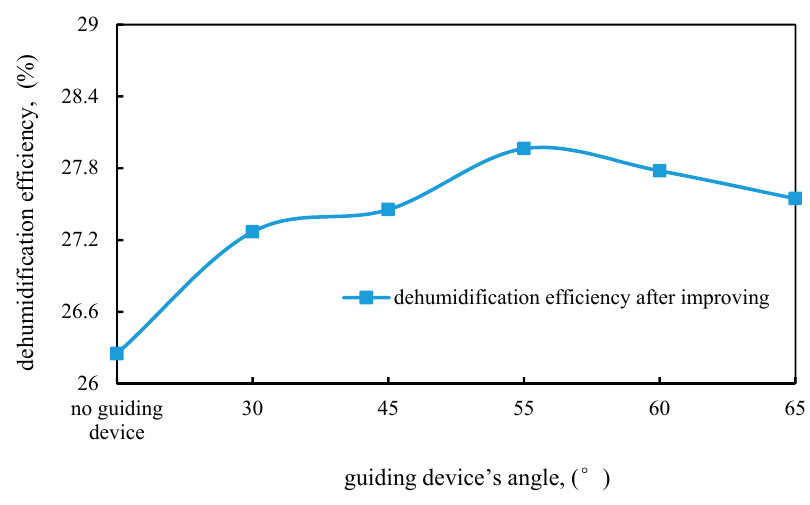
Figure 9. The influence of different diversion device angles on separation efficiency. Table 3. Comparisons of optimized results with field data.